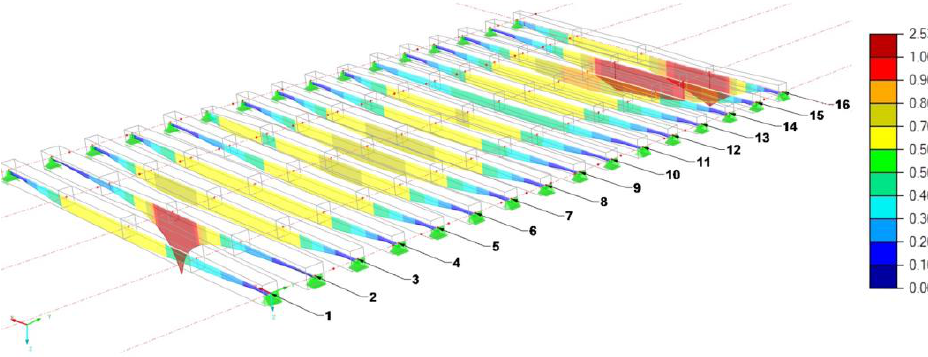
Figure 25. Fire resistant diagram of the different beams of the floor (% of the maximum capacity). The sections marked in red among the beams indicate reaching 100% of the fire capacity.